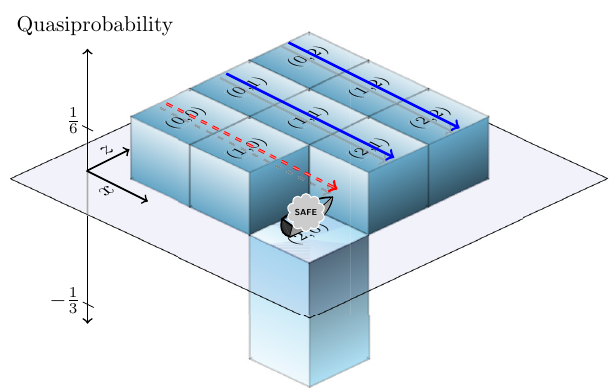
FIG. 5. The perfect quantum strategy can be understood by plotting the discrete Wigner function of the message state sent by Alice. In the above qutrit case, Alice is in coordinate ( x , z ) = (cid:4) (cid:5) (cid:4) ψ ( 2, 0 ) , so she sends Bob the state whose Wigner function 2,0 is − 1 / 3 at coordinate ( 2, 0 ) and 1 / 6 otherwise. Bob measures this state along any of the four allowed directions, wherein the probability of each outcome is given by sum of quasiprobabili- ties along the corresponding line. Hence, the only outcomes with nonzero probability of occurring correspond to lines not passing through ( 2, 0 ) . Whichever outcome Bob sees, he may fire his tor- pedo along the corresponding line, safe in the knowledge that it will not intersect Alice’s ship. In this figure the solid blue lines correspond to the possible outcomes for the q = 0 direction, but the same argument holds for all the other directions.